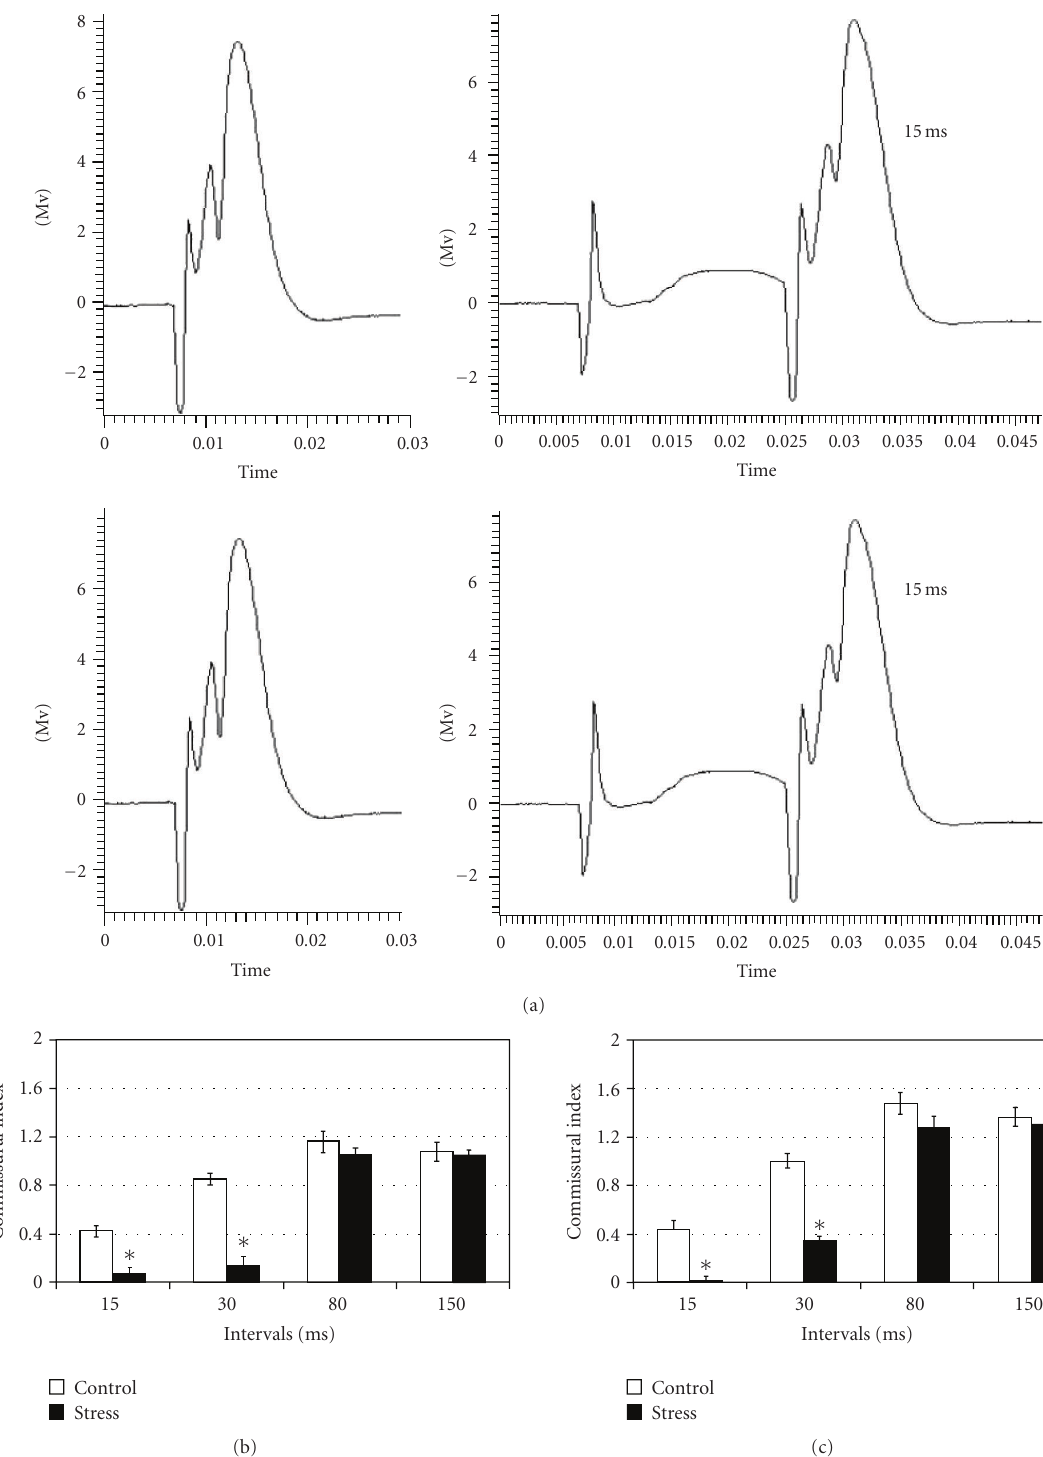
Figure 3: (a) The e ff ects of commissural priming on responses of the DG to PP stimulation . Top: representative field potential responses of dentate gyrus cells to stimulating the PP without commissural priming (left), and to stimulating the PP with priming stimulation to the con- tralateral DG at 15 milliseconds (right) in control rats. Bottom: representative field potential responses of dentate gyrus cells to stimulating the PP without commissural priming (left), and to stimulating the PP with priming stimulation to the contralateral DG at 15 milliseconds (right) in stressed rats. Time unit: second. (b) Commissural-induced modulation prior to TBS application . Commissural-induced inhibition was significantly higher in stressed rats ( n = 6) at 15-millisecond and 30-millsecond interpulse intervals in comparison with control rats ( n = 6) ( P < .05). (c) Commissural-induced modulation following TBS application . Commissural-induced inhibition was significantly higher in stressed animals at 15-millisecond and 30-millisecond intervals n = 6 ( P <